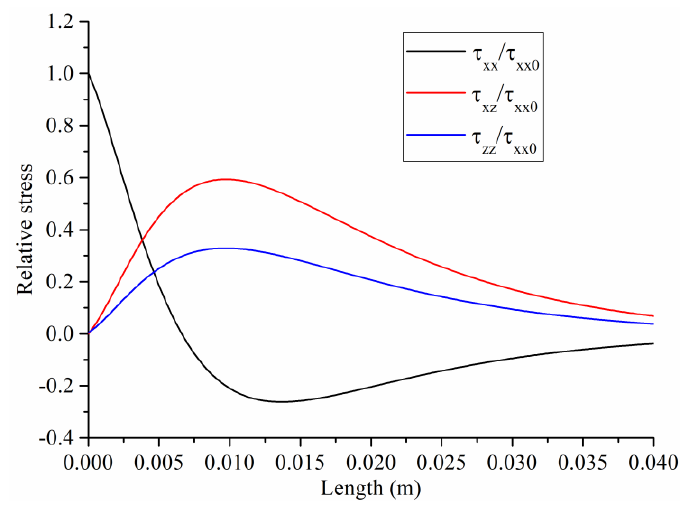
Figure 4. Stress amplitudes as function of depth.